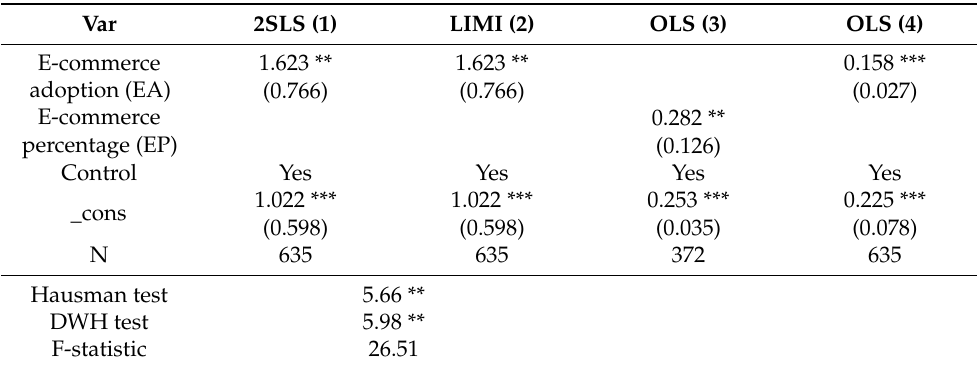
Table 4. Baseline regression